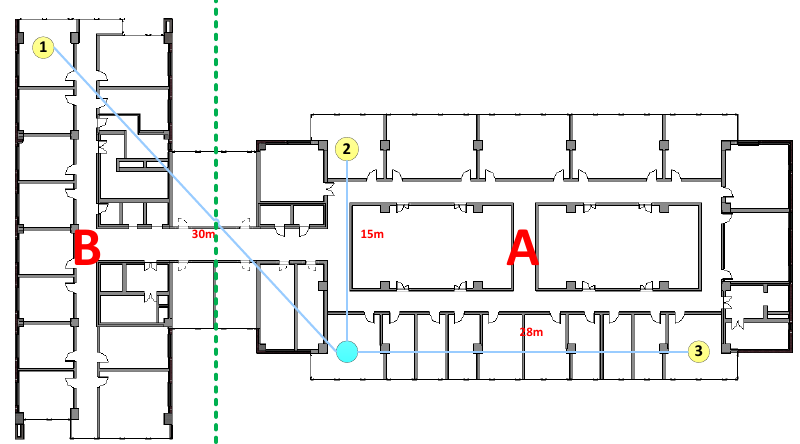
Figure 4. Floor-level detail of measured building.